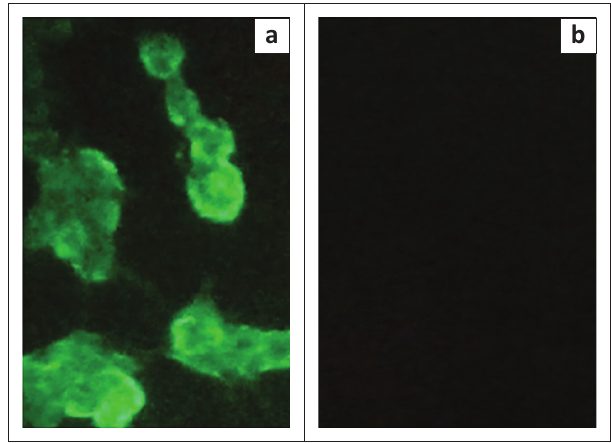
FIGURE 1: Verification of G1 protein expression in immunofluorescence staining. (a) Image of the transfected human embryonic kidney 293 (HEK 293) cells with the pcDNA3.1-G1 construct obtained by a fluorescence microscope and (b) transfected HEK 293 cells with empty pcDNA3.1 plasmid used as negative control.